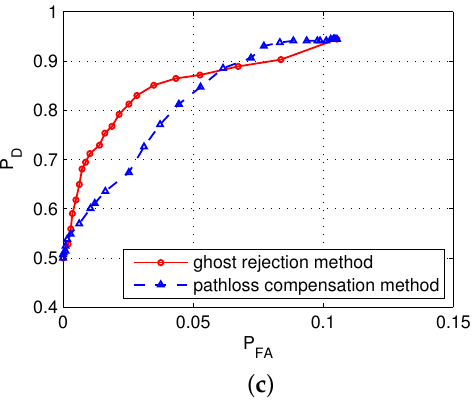
Figure 8. Receiver operating characteristic (RoC) curves for each scenario. ( a ) Scenario 1; ( b ) Scenario 2; and ( c ) Scenario